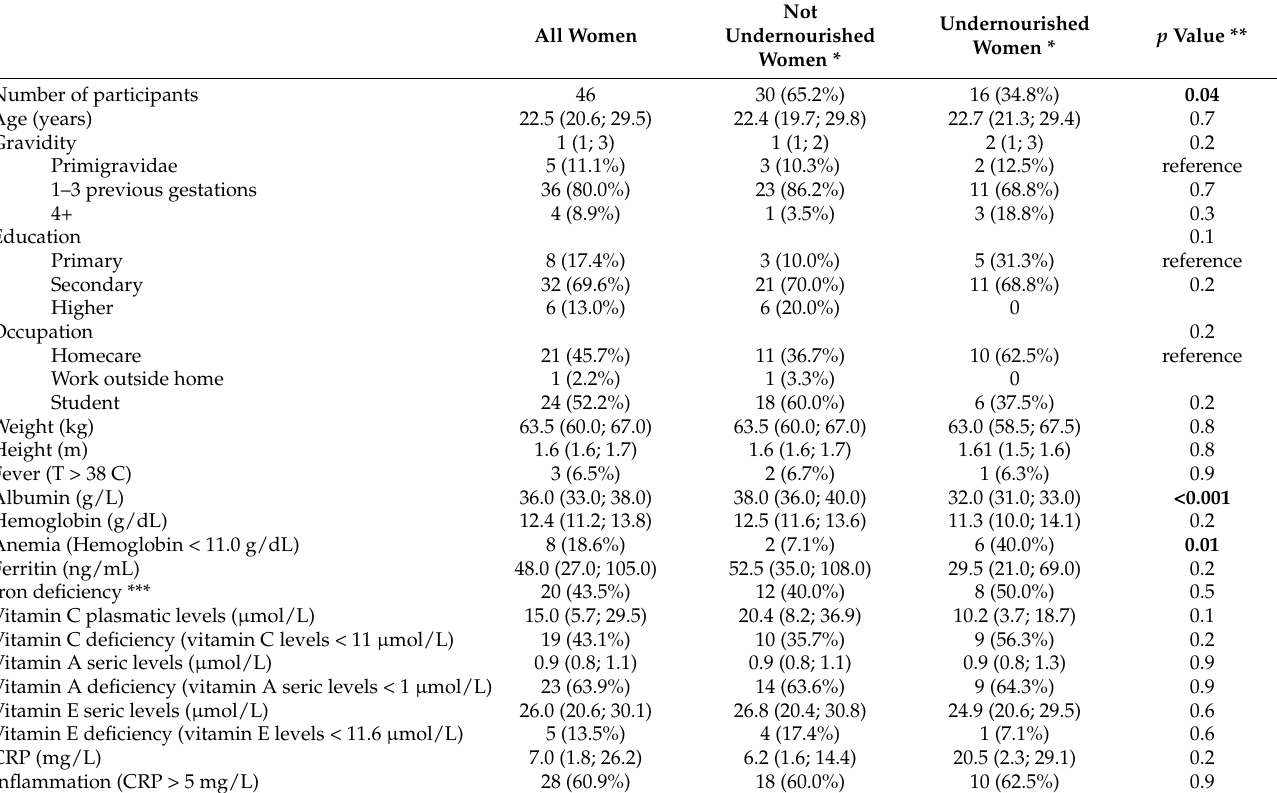
Table 1. Baseline characteristics of the women that were included in the MITICA study for whom we had an albumin measurement at delivery. Not Undernourished All Women Undernourished Women Women *